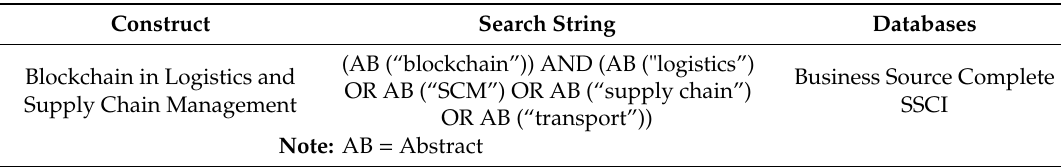
Table 2. Keywords and search string.